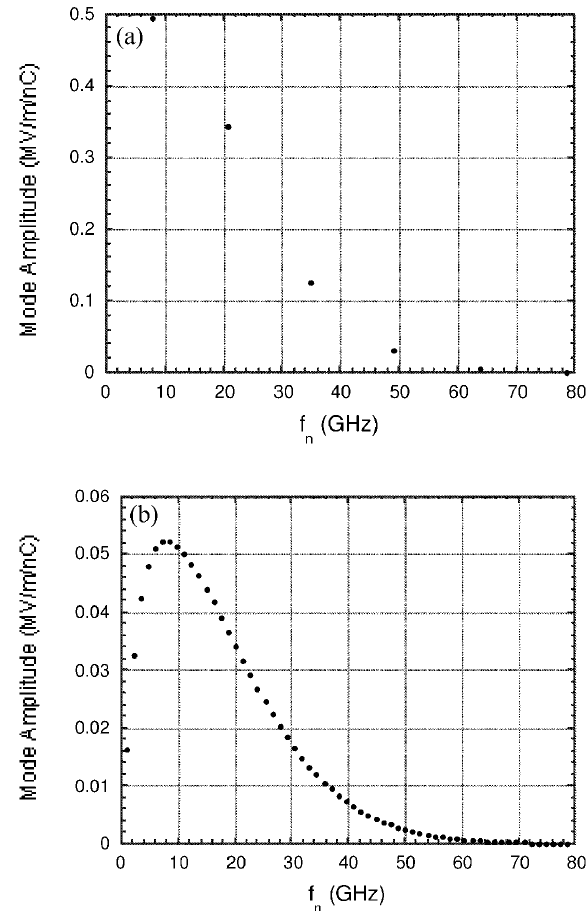
FIG. 4. (a) Amplitude spectrum for the single-mode structure. The TM 01 mode ( f 1 (cid:1) 7.8 GHz) is the dominant mode excited. (b) Amplitude spectrum for the multimode structure. The TM 07 mode ( f 7 (cid:1) 8.5 GHz) is the dominant mode excited, but many other modes are strongly excited as